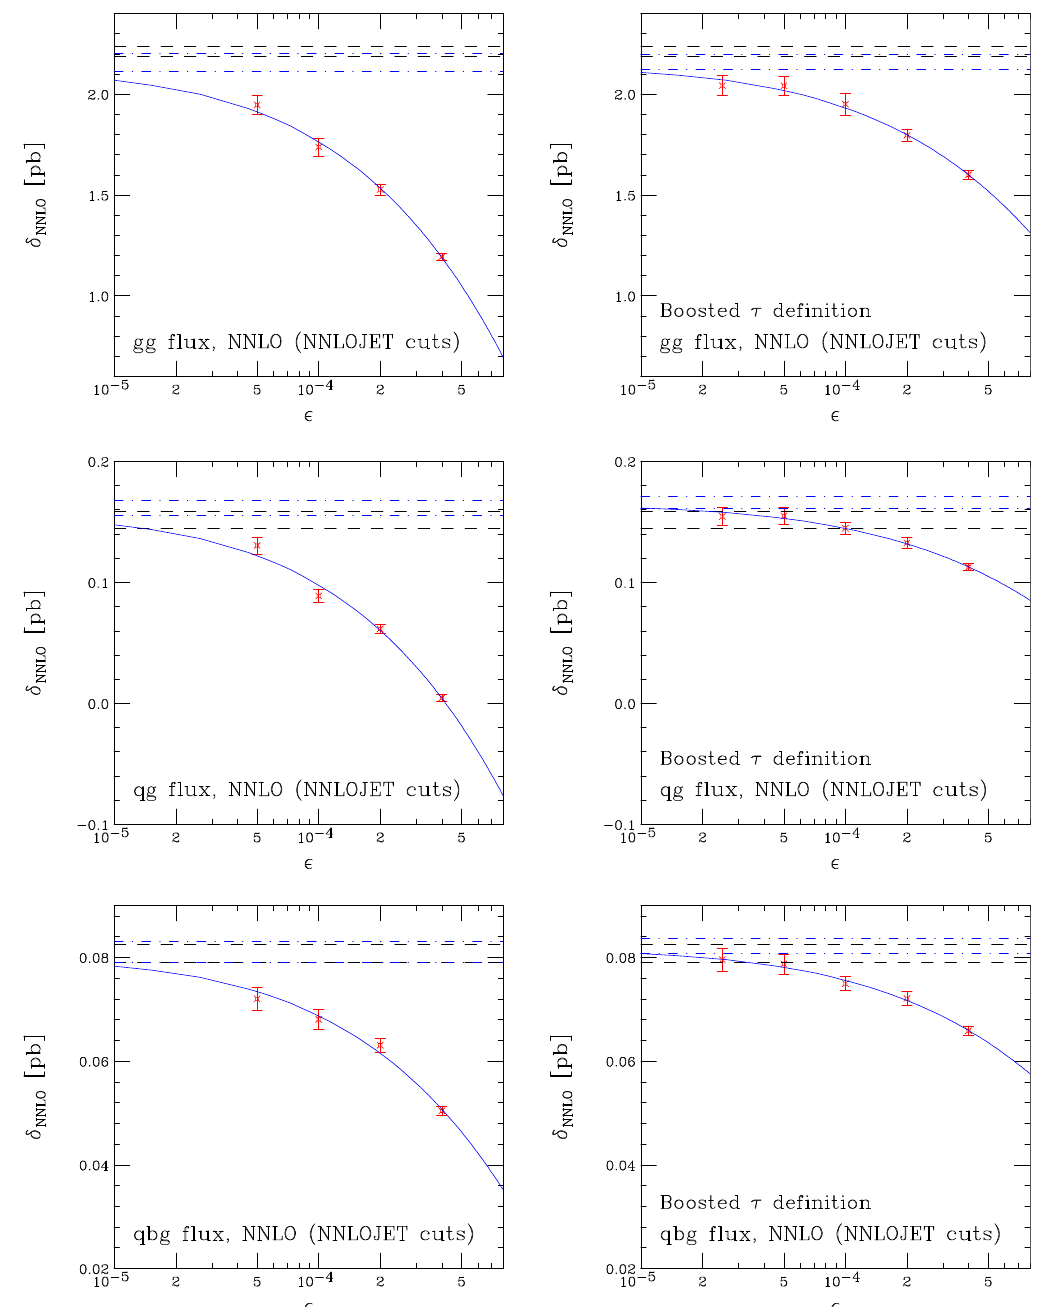
Figure 4 . (cid:28) -dependence of NNLO coe(cid:14)cients for the gg , qg and (cid:22) qg partonic channels, in the NNLOJET setup. The plots on the left show the result when T 1 is computed in the hadronic c.o.m. and the ones on the right indicate the corresponding result when evaluating this quantity in the boosted frame. The (blue) solid lines correspond to the (cid:12)t form in eq. (3.5), with the dot-dashed lines representing the errors on the asymptotic value of the (cid:12)t. The NNLOJET result, including its associated uncertainty, is shown as the band enclosed by the black dashed lines.